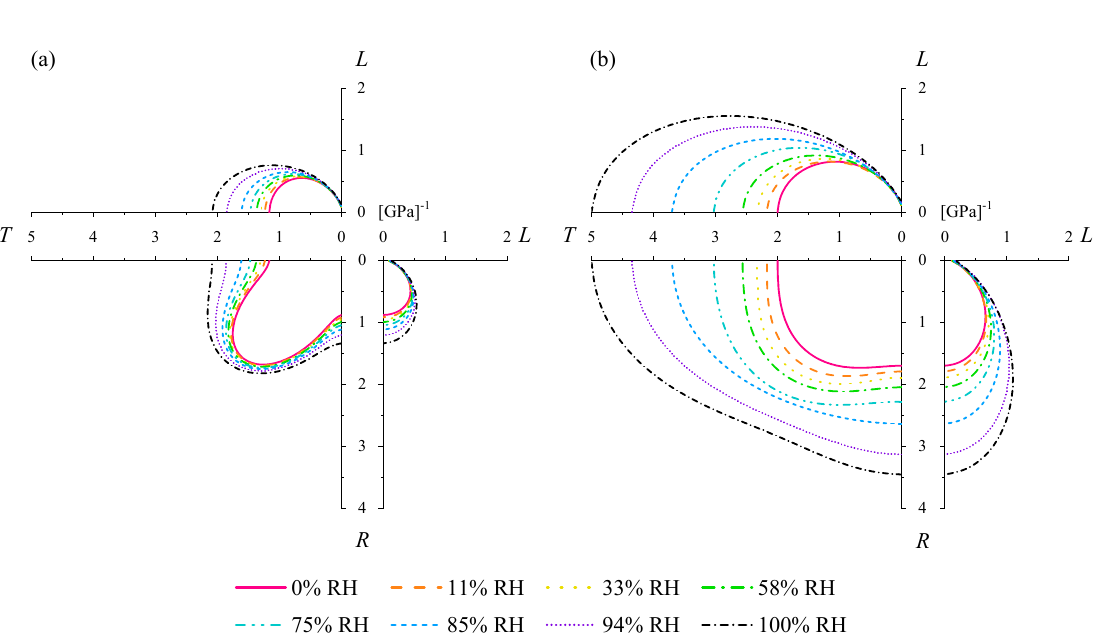
Figure 3. Load-directional dependence of poplar ( a ) and Chinese fir ( b ) wood compliance via polar diagrams for the principal planes of anisotropy.